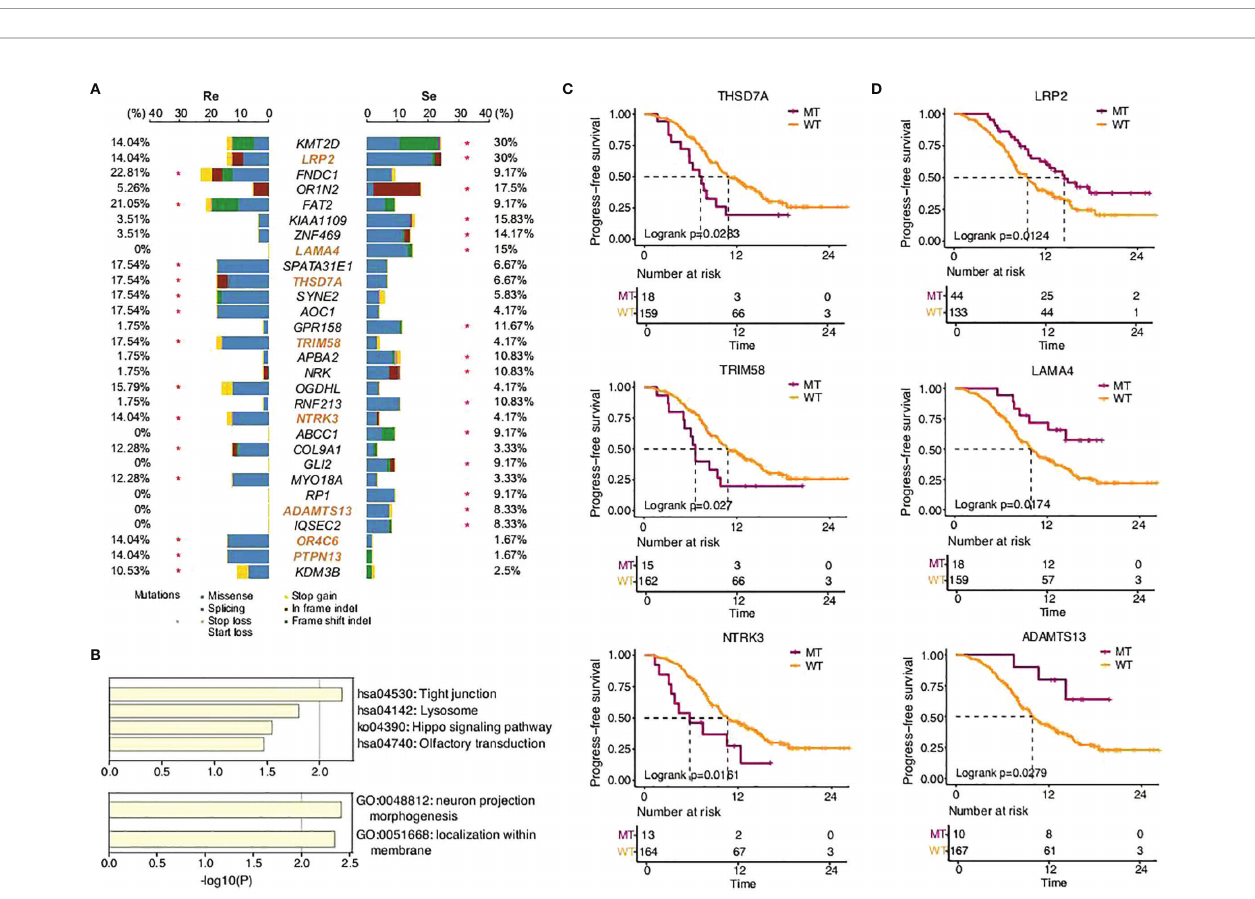
FIGURE 1 | Small cell lung cancer (SCLC) patients ’ mutational signature and the weights of different somatic mutational signatures in each